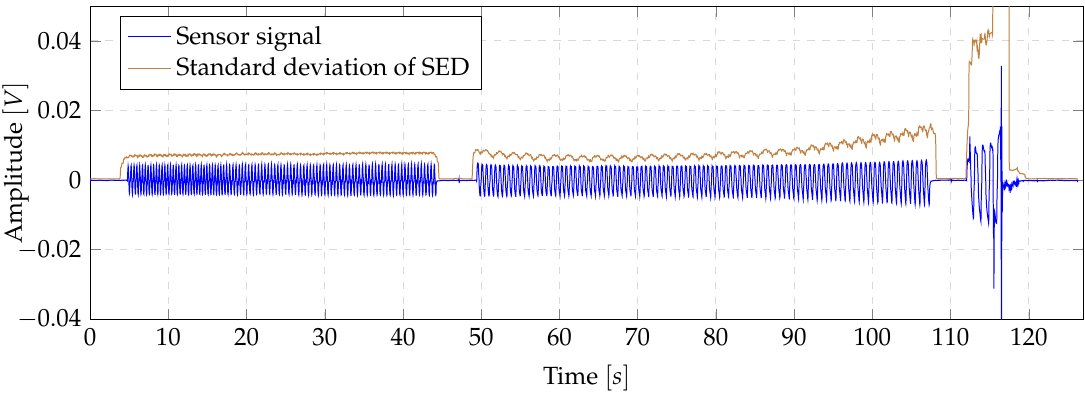
Figure 4. Characteristic of the standard deviation of the SED found in the preliminary study in comparison to the normalized sensor